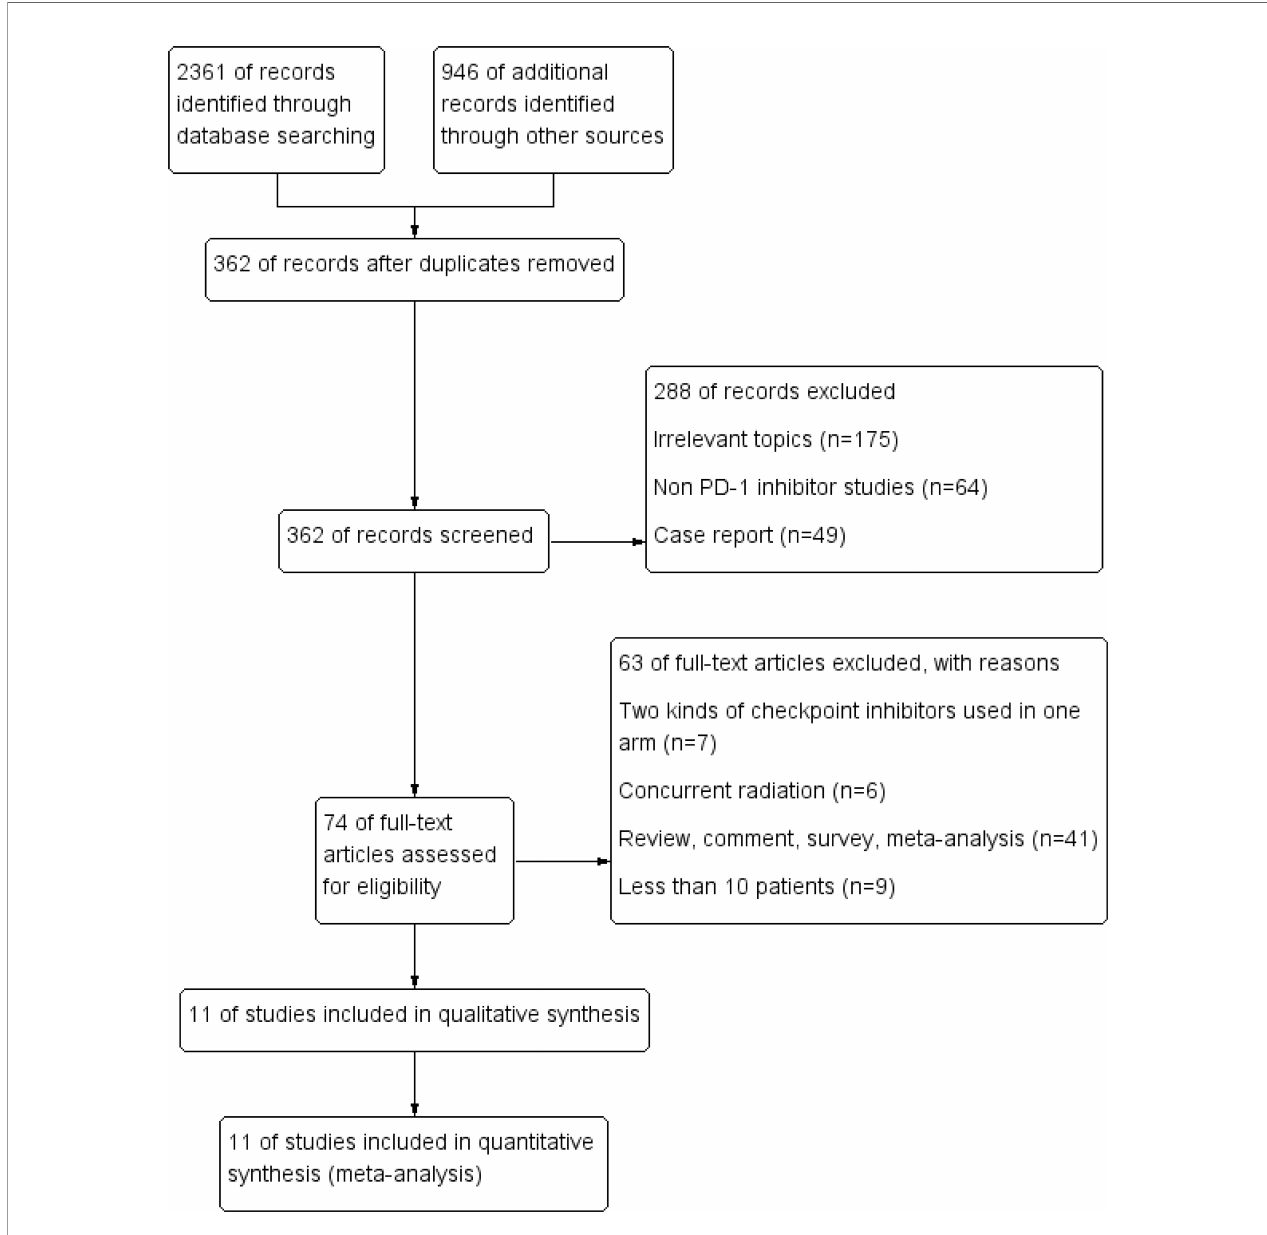
FIGURE 1 | PRISMA fl ow